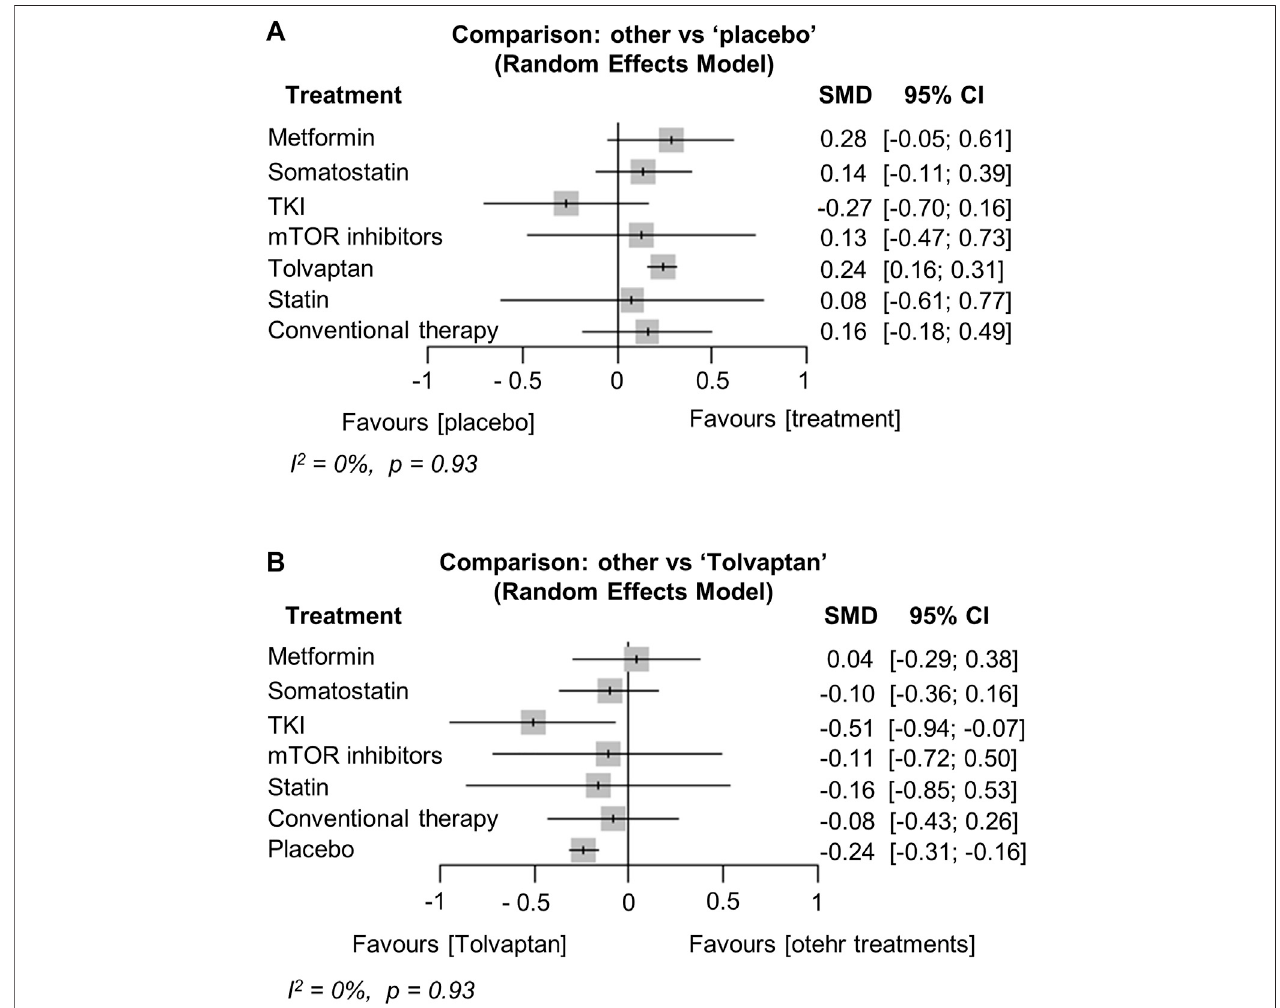
FIGURE 2 | Network meta-analysis reporting the standard mean difference (SMD) for each treatment effect of preserving kidney function (glomerular fi ltration rate) compared to (A) the placebo and (B) tolvaptan in ADPKD patients. CI, con fi dence interval; TKI, tyrosine kinase inhibitor; ADPKD, autosomal dominant polycystic kidney